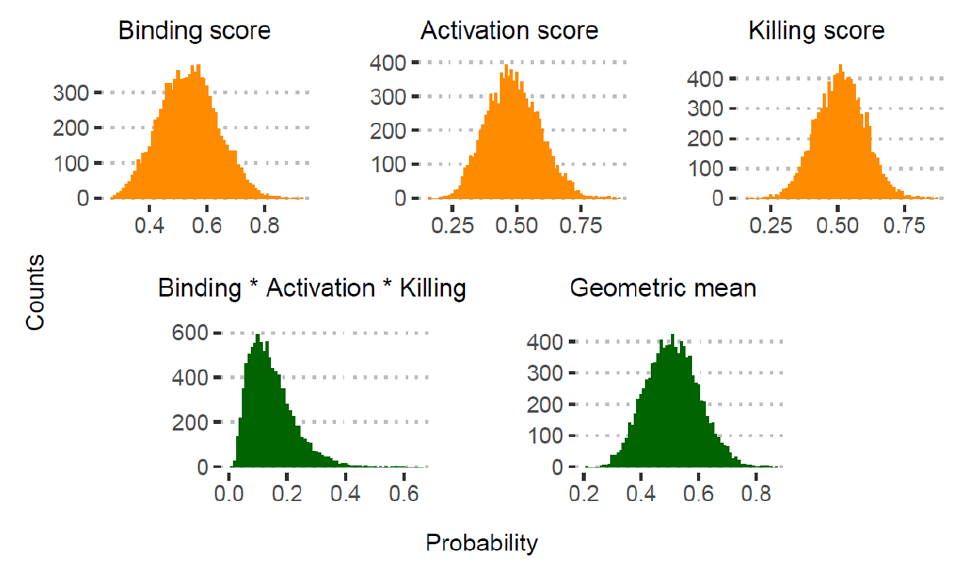
Figure 4. Distribution of 1G4 TCR positional weight matrix scores for 2019-nCoV peptides. The positional weight matrices were obtained from 7 and 9613 9-mers generated from 10 2019-nCoV ORFs were computed for their TCR recognition